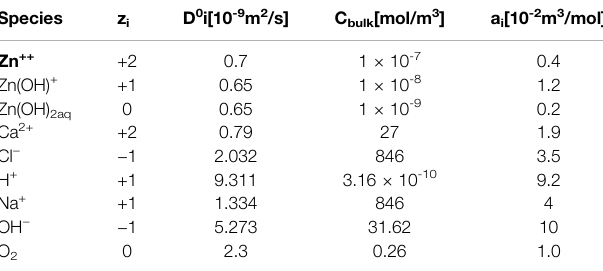
Table 1 . The rate constants, k f and k b , of chemical reactions were